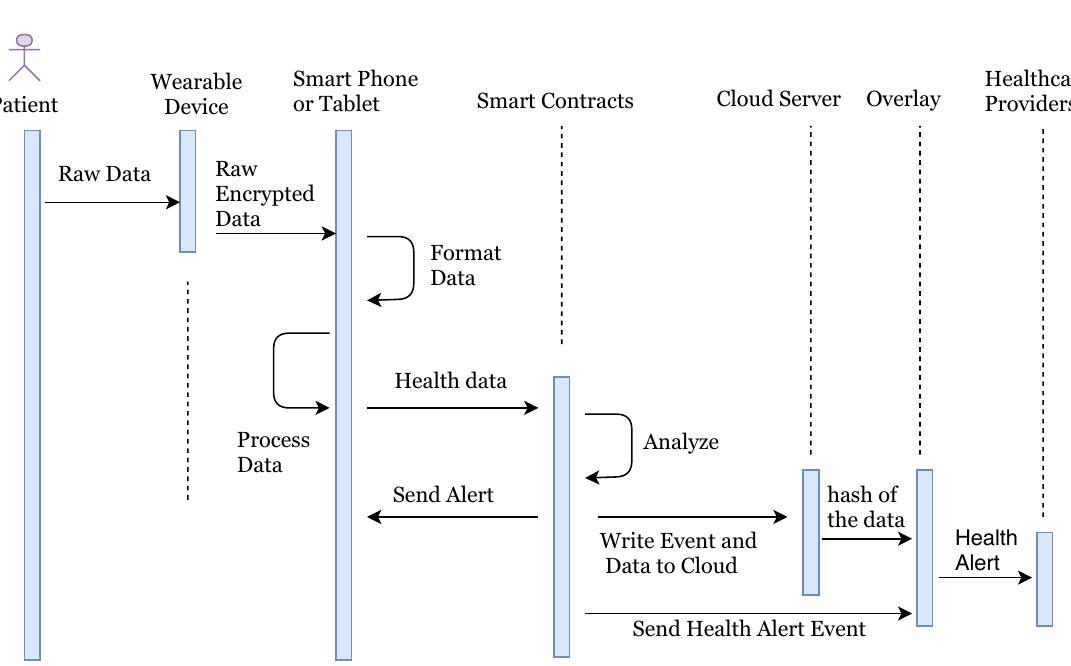
Figure 12. Logical flow execution of the